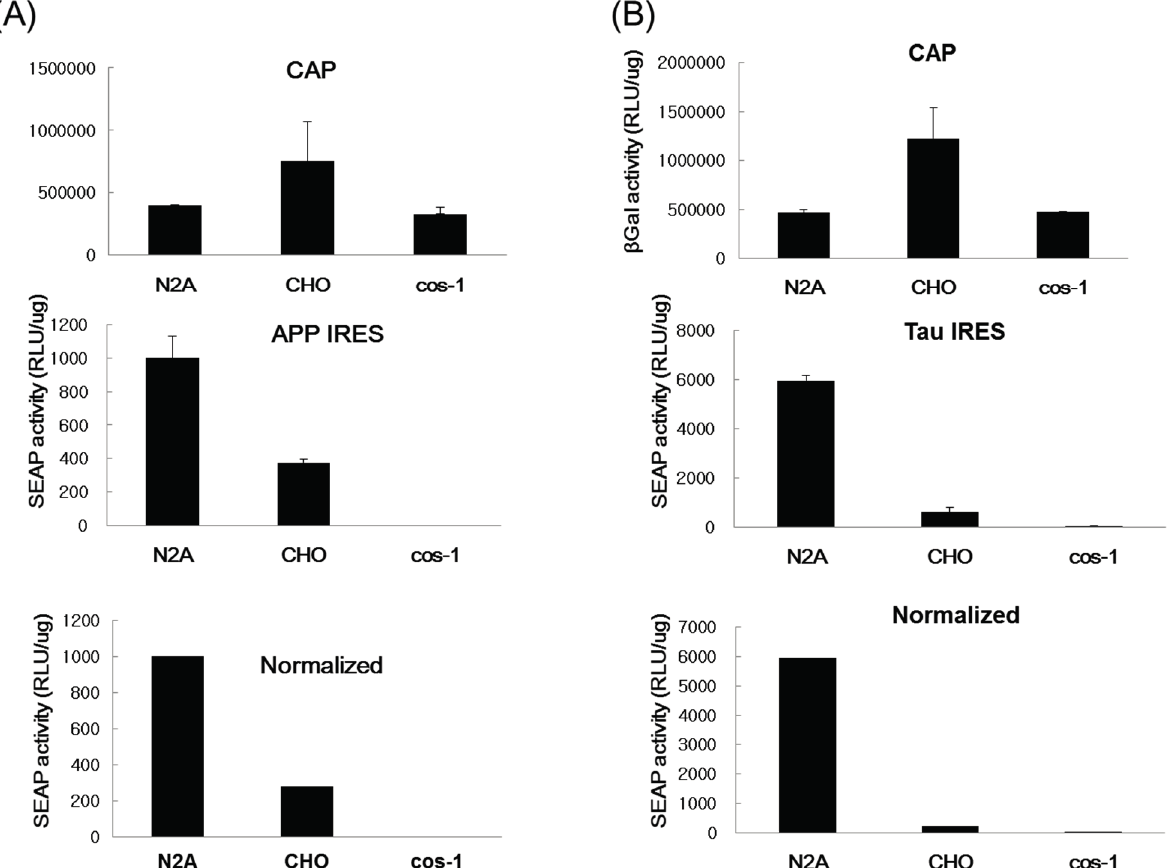
Figure 2. Determination of cell tropism of the APP and tau IRES. Transient transfection with the corresponding plasmid was performed on mammalian cells (~9 × 10 4 cells/well) of different types using Lipofectamine 2000. Cap-dependent mechanism of translation was assessed by β -galactosidase activity in the cell lysate while the IRES-dependent mechanism of translation was ascertained through the SEAP activity in the cell medium. Normalization was carried out by β -galactosidase assay. ( A ) Comparison of the APP IRES and ( B ) Tau IRES activity in mouse N2A, CHO and COS-1